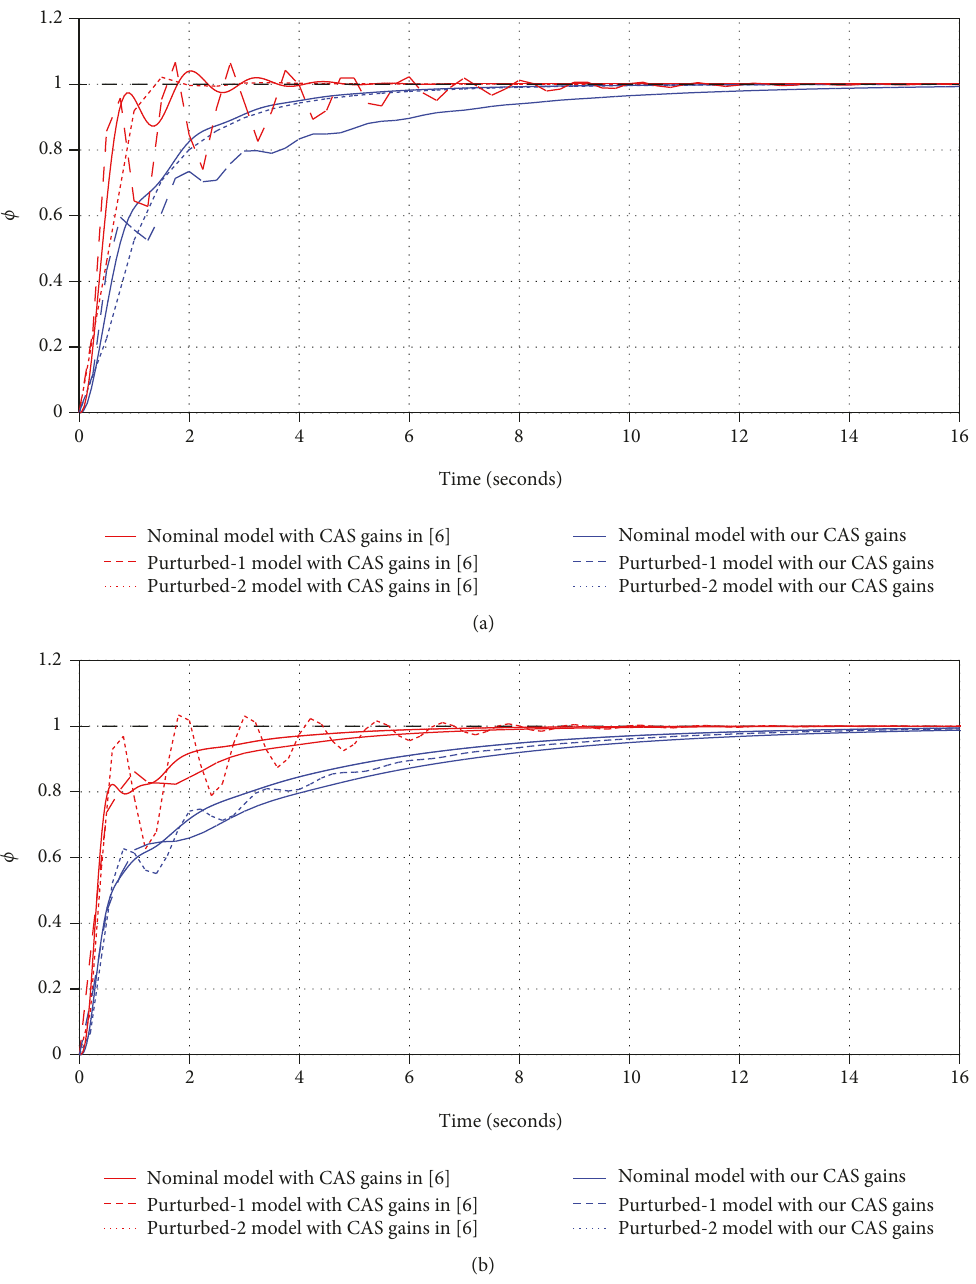
Figure 8: Step responses using oscillation suppressing CAS gains in Table 2 and CAS gains in [6] at design point 4 (T30) (a) and design point 3 (T50)